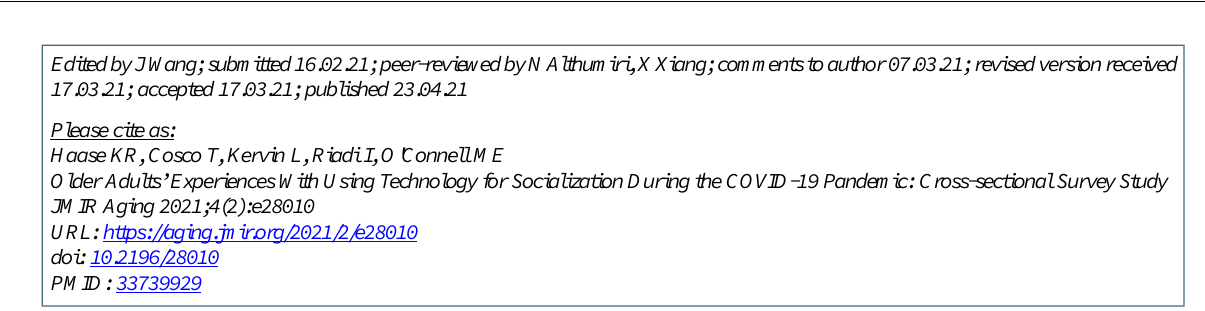
r : point-biserial correlation coefficient pb r : Spearman rank correlation s